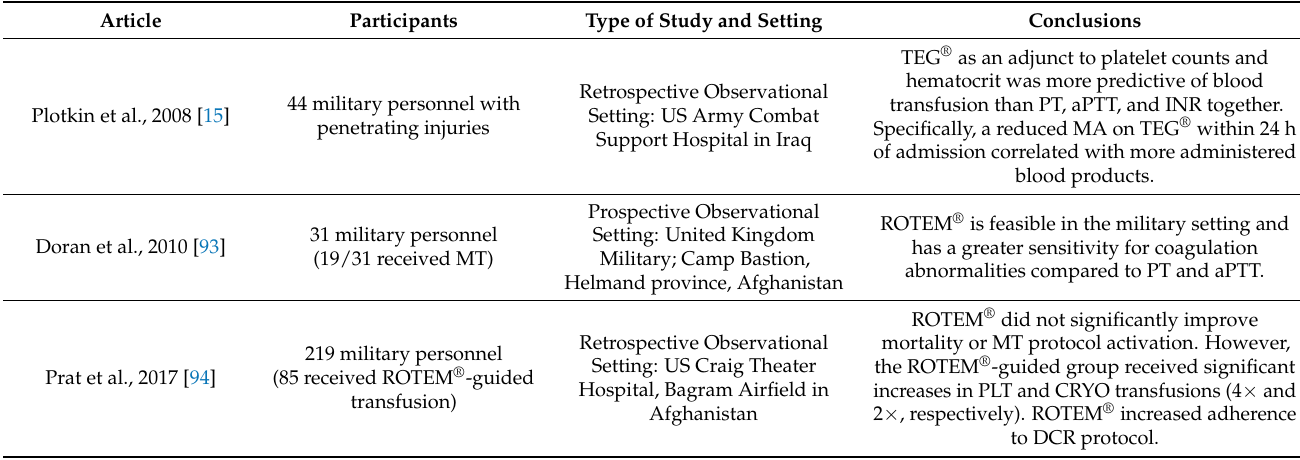
Table 1. Summary of military literature investigating VHA-guided